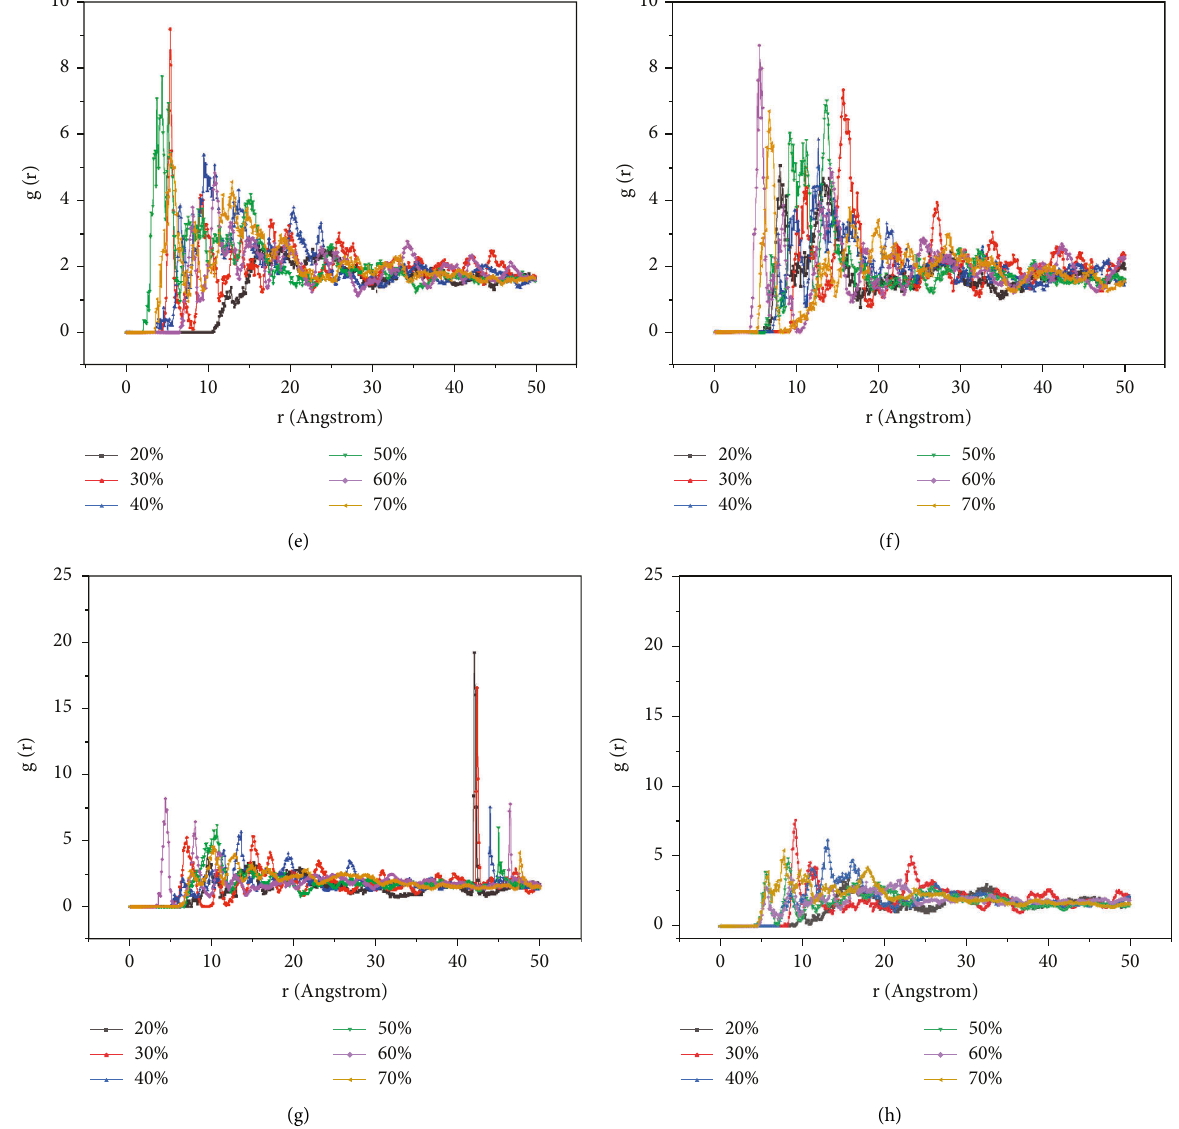
Figure 9: RDF curves of six components in CRMAs: (a) asphaltene-asphaltene; (b) asphaltene-aromatic; (c) asphaltene-resin; (d) asphaltene-saturate; (e) asphaltene-rubber; (f) asphaltene-waste oil; (g) rubber-rubber; (h) rubber-waste